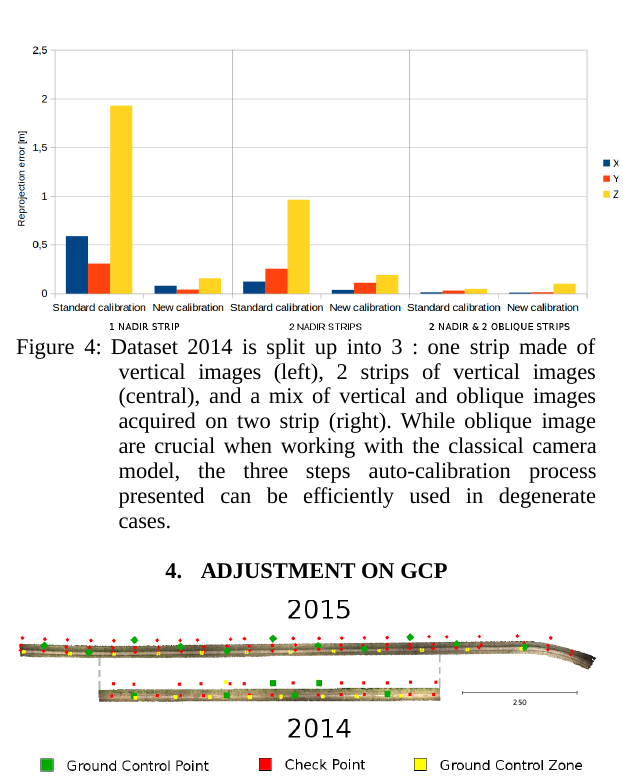
Figure 5: Configuration of the topographic networks on the acquisitions A set of relative orientations can be useful for visual purposes. In the cases studied, GCP are needed to georefence the site, and especially to overcome the remaining imprecision of the orientations.